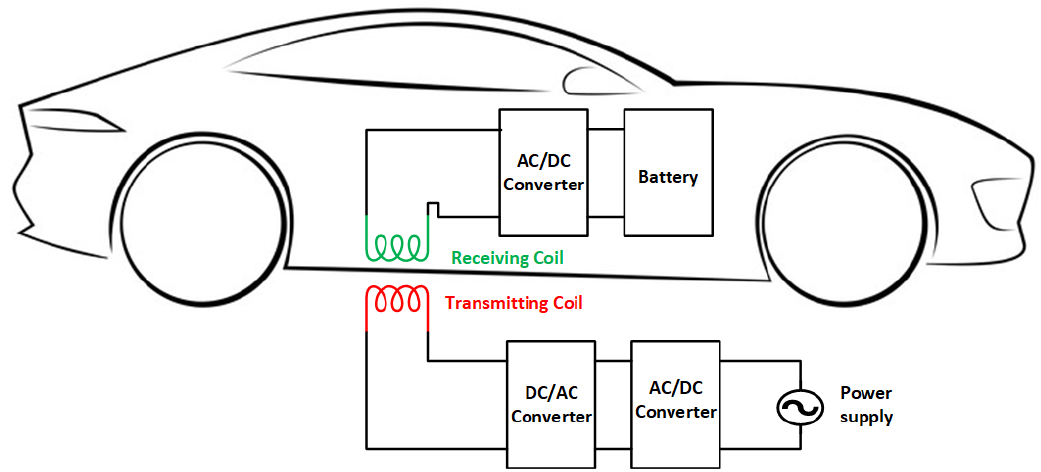
Figure 4. A simplified diagram of inductive charging.